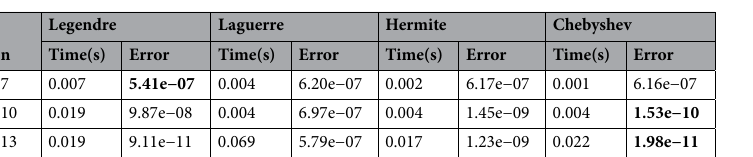
Table 12. Comparision of maximum relative error of z 1 ( t ) for Example 7.3 with different numbers of neurons. Significant values are in